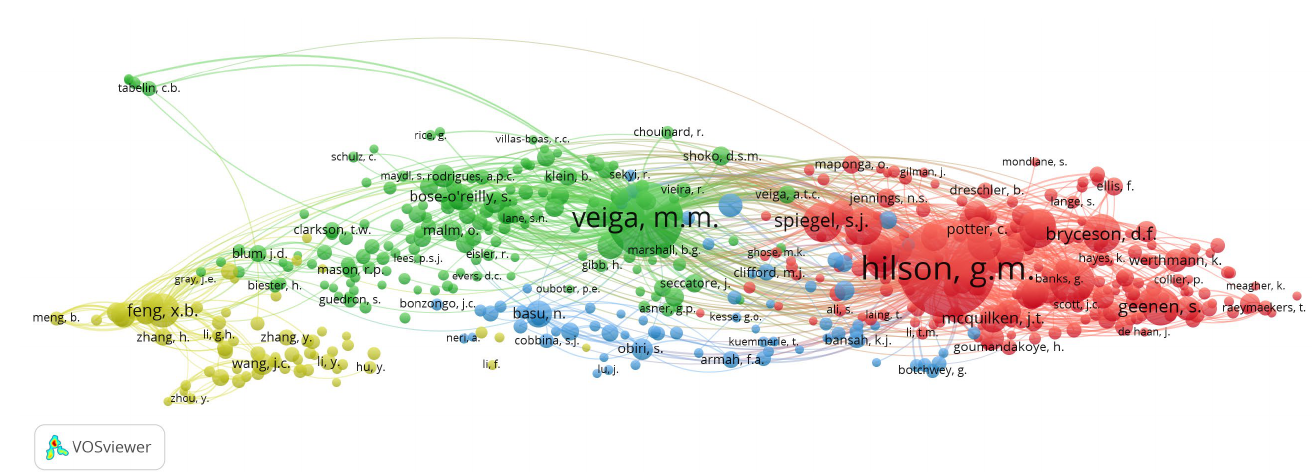
Figure 7. Co-citation network of authors in ASM.